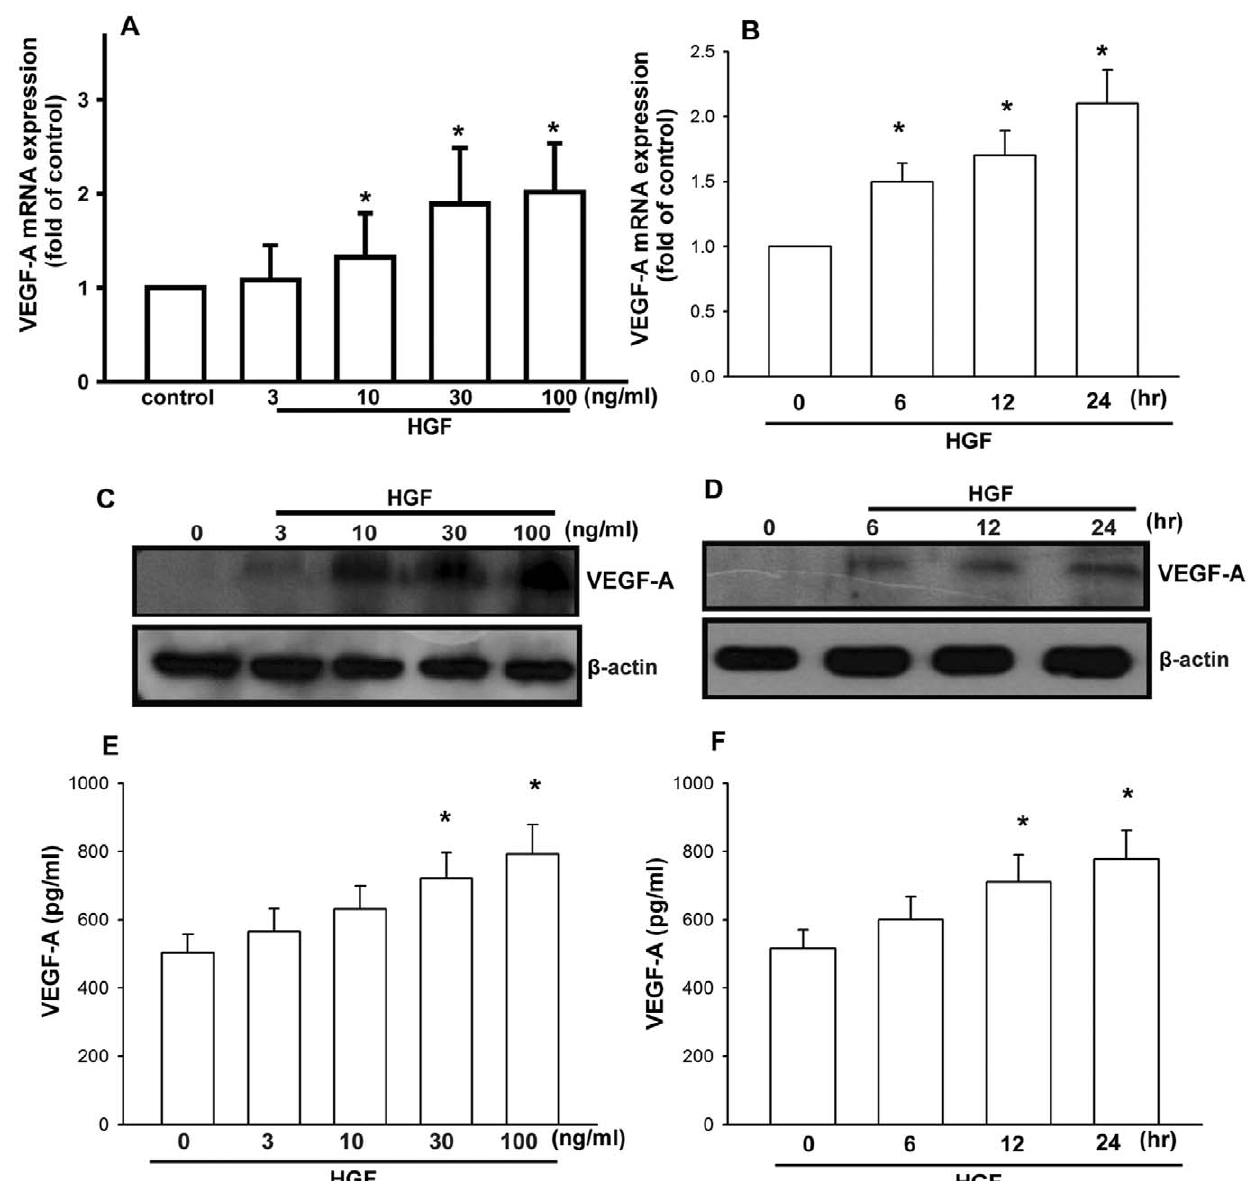
Figure 1. HGF stimulates concentration- and time-dependent increases in VEGF-A production. OASFs were incubated with HGF (3– 100 ng/ml) for 24 h (A) or with HGF (30 ng/ml) for 6, 12, or 24 h (B), and VEGF-A mRNA was examined by qPCR. (C–F) OASFs were incubated with HGF (3–100 ng/ml) for 24 h or with HGF (30 ng/ml) for 6, 12, or 24 h, and VEGF-A protein expression was examined by Western blotting (whole cells lysate) and ELISA (medium). Results are expressed as the mean 6 S.E. *, p , 0.05 compared with control; # , p , 0.05 compared with HGF-treated group.